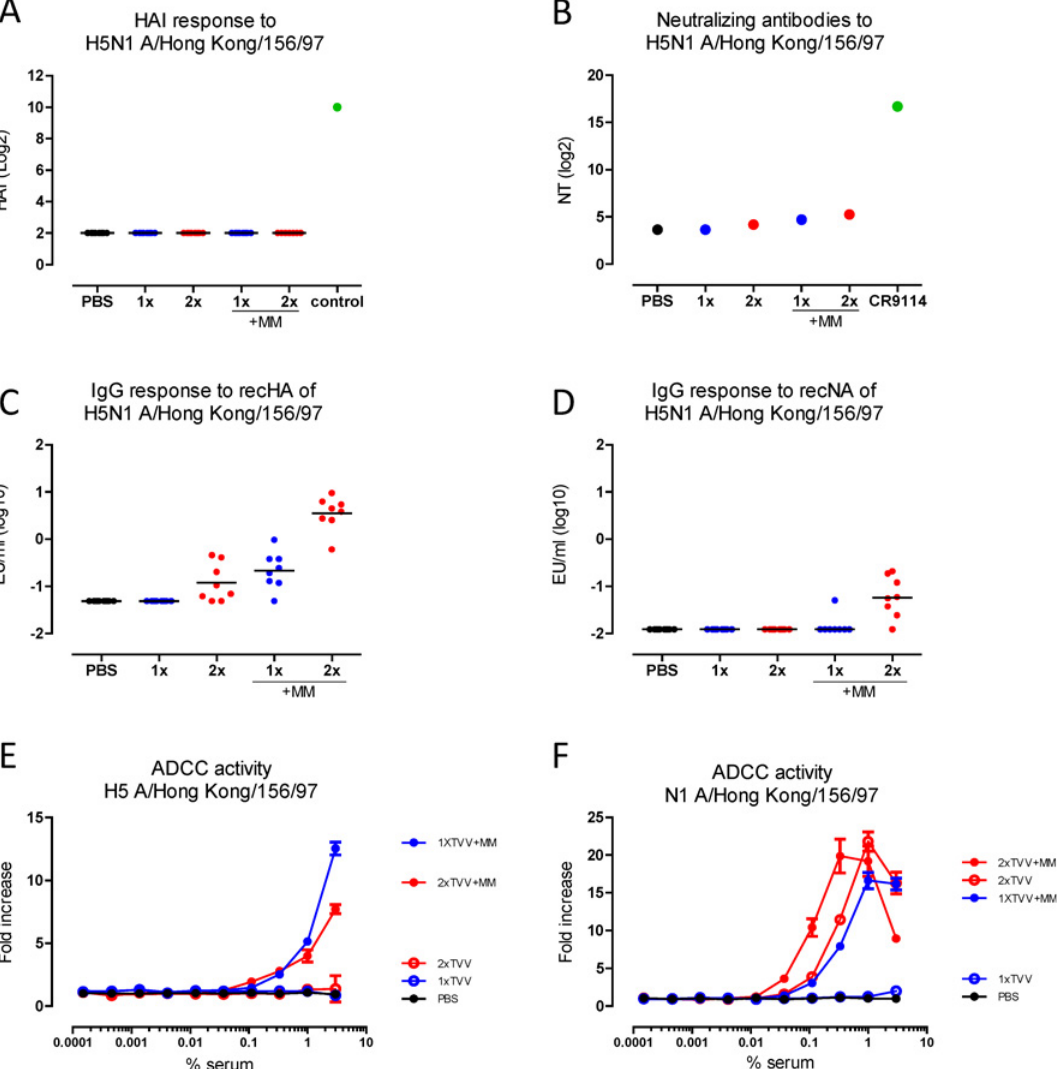
Fig 2. Cross-reactive HA and NA-specific ADCC responses are induced by TVV+MM. Mice (n = 8/group) were immunized once or twice with TVV or TVV+MM. Three weeks later, serum samples were obtained and tested for H5N1 A/Hong Kong/156/97 cross-reactive HAI responses (A), neutralizing antibody responses (B), HA-specific antibodies (C) and NA-specific antibodies (D) or ADCC responses against H5 expressing cells (E) or N1 expressing cells (F). Black bars indicate medians of log-2 transformed HAI and neutralizing titers (NT) or log-10 transformed ELISA titers (EU). Error bars in ADCC assays indicate the standard error of the duplicate means. Control in HAI assay = H5/HK specific sheep serum.